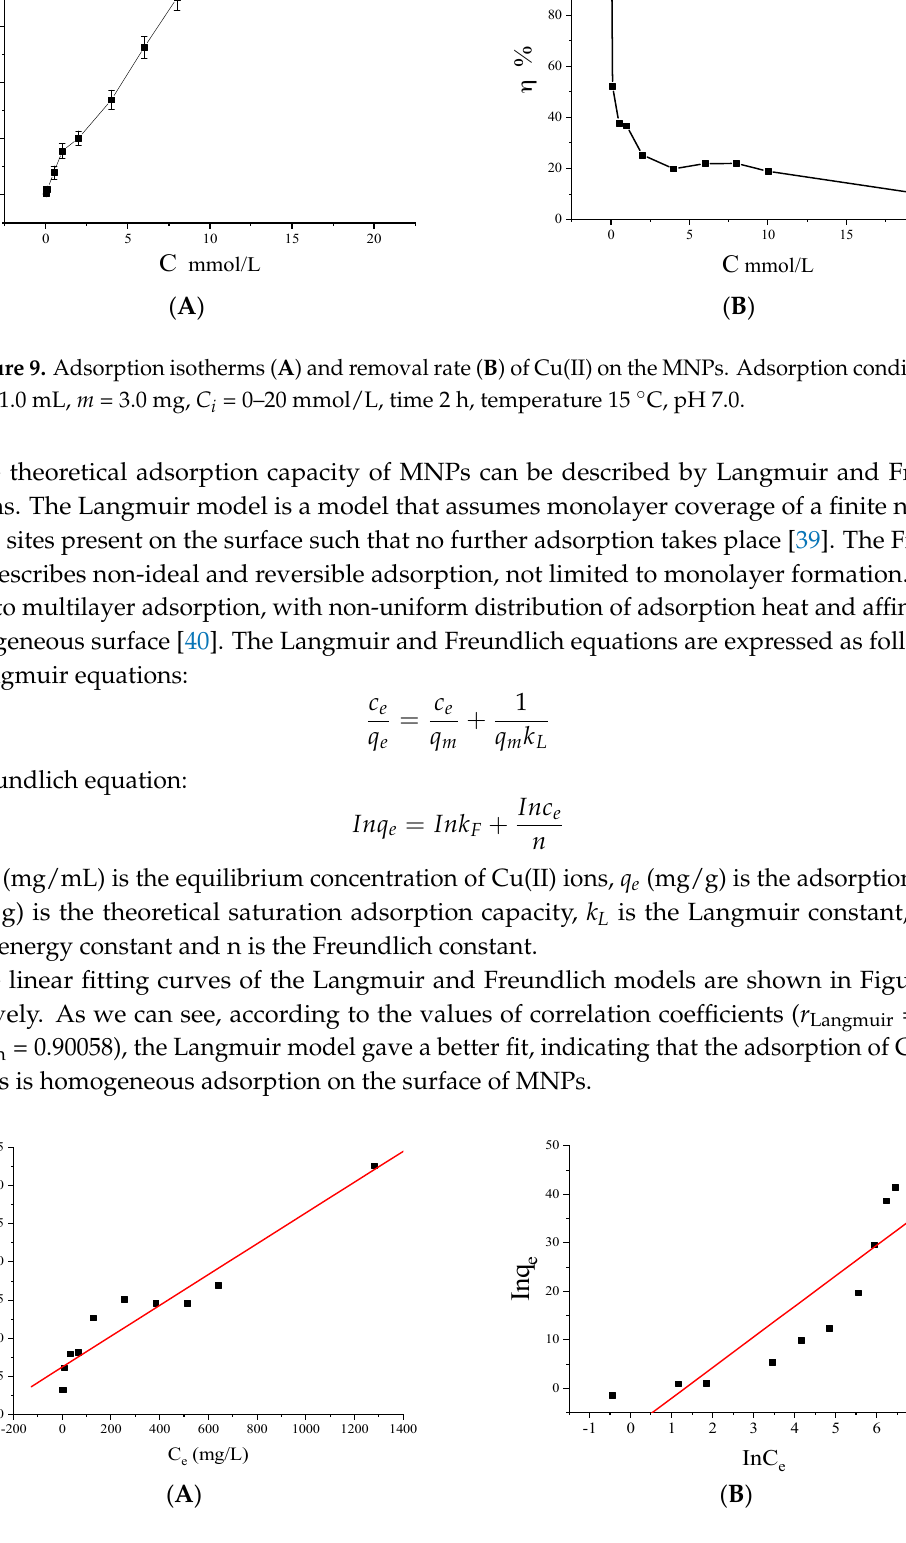
( C ) Figure 8. Effect of time ( A ), pseudo-first-order ( B ) and pseudo-second-order ( C ) kinetic models for Cu(II) adsorption. V = 1.0 mL, m = 3.0 mg, C i = 1.0 mmol/L, temperature 15 °C, pH 7.0, time 2 h. Table 1 Adsorption kinetic parameters for Cu(II) adsorption on MNPs. Q e , exp